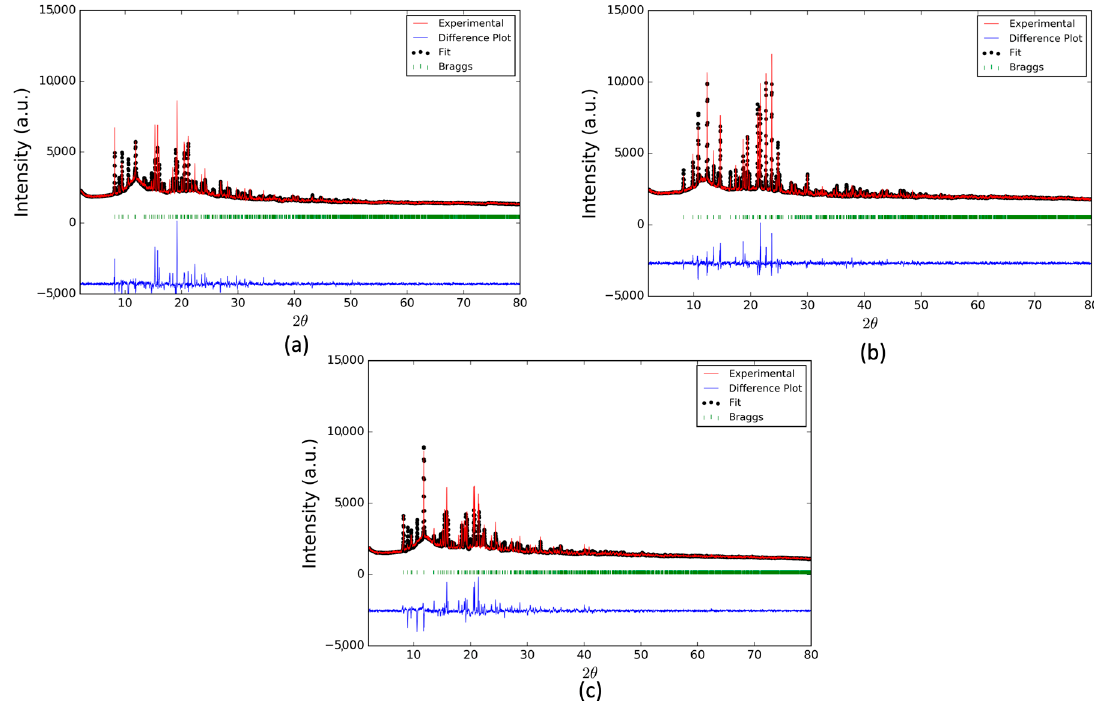
Figure 4. Laboratory powder X-ray diffraction (CuK α radiation) patterns (red lines) for ( a ) [{Co( rac - Laboratory powder X-ray di ff raction (CuK α radiation) patterns (red lines) for ( a ) 2 ) 2 (NCS) 2 } · CHCl 3 ] n , ( b ) [Co( 3 ) 2 (NCS) 2 ] n and ( c ) [{Co( 4 ) 2 (NCS) 2 } · CHCl 3 ] n at room temperature [{Co( rac - 2 ) 2 (NCS) 2 } · CHCl 3 ] n , ( b )[Co( 3 ) 2 (NCS) 2 ] n and( c )[{Co( 4 ) 2 (NCS) 2 } · CHCl 3 ] n atroomtemperature, ,compared to the fitted patterns from the single-crystal X-ray diffraction data (black dots). The green compared to the fitted patterns from the single-crystal X-ray di ff raction data (black dots). The green lines denote the Bragg peak positions, and blue trace shows the difference between experimental and lines denote the Bragg peak positions, and blue trace shows the di ff erence between experimental and calculated points. calculated